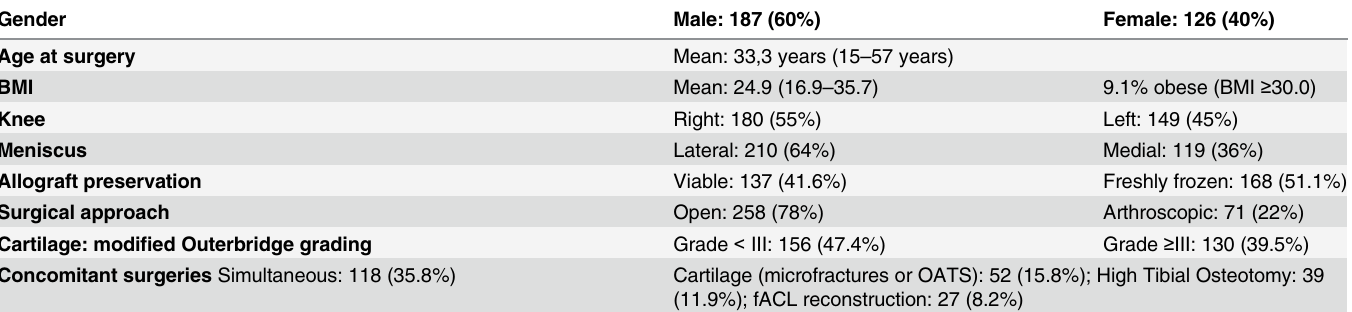
Table 1. Patient Demographics: 329 Meniscal Allograft Transplantations in 313 patients.